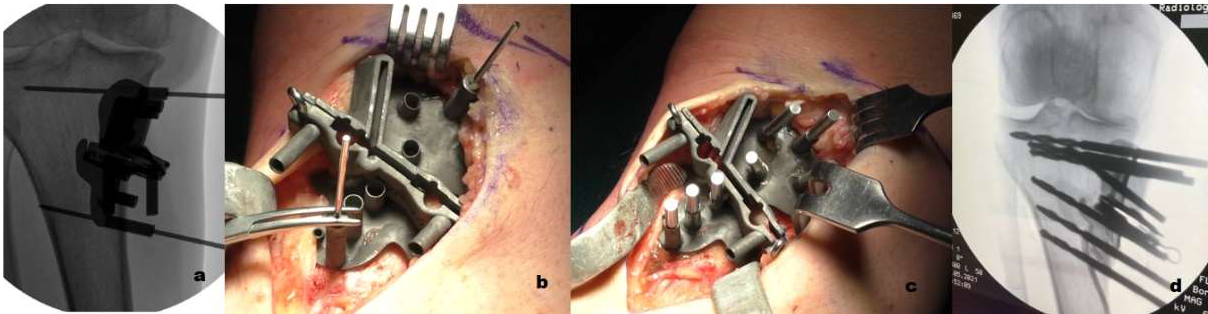
Figure 4. ( a ) A synthetic fluoroscopic image to aid the surgical guide positioning was produced. ( b )